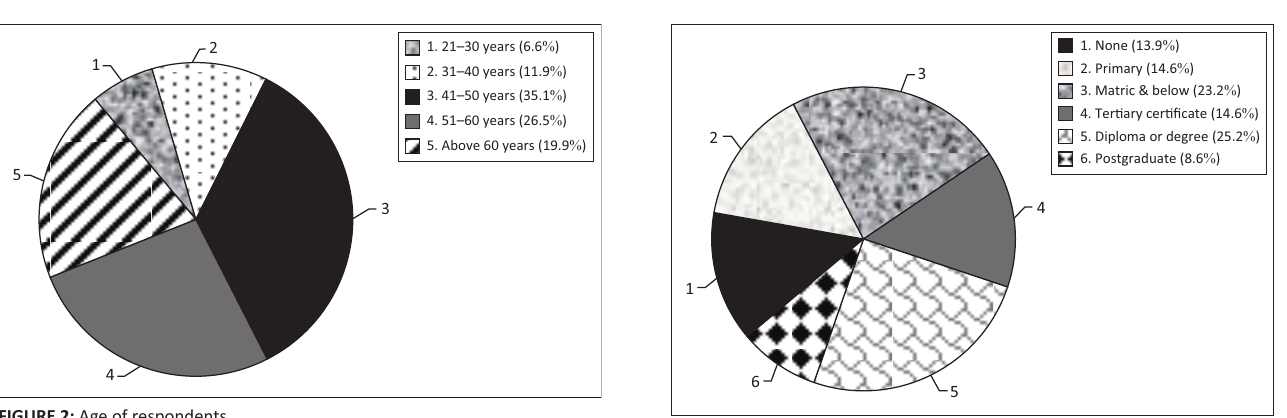
FIGURE 3: Levels of academic qualification.